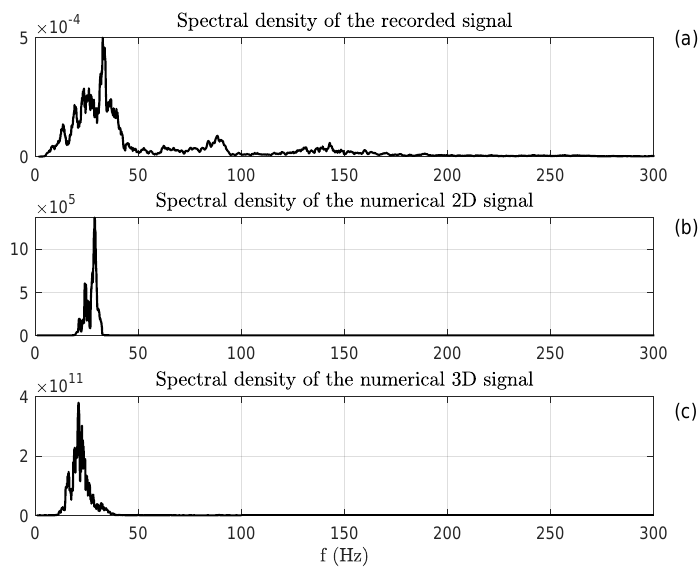
Figure 4. Spectral signal recorded by the GoPro after the earthquake ( a ) and spectral signal of the hydro-acoustic waves reproduced numerically by the 2D model of [13] ( b ) and by the present 3D model ( c